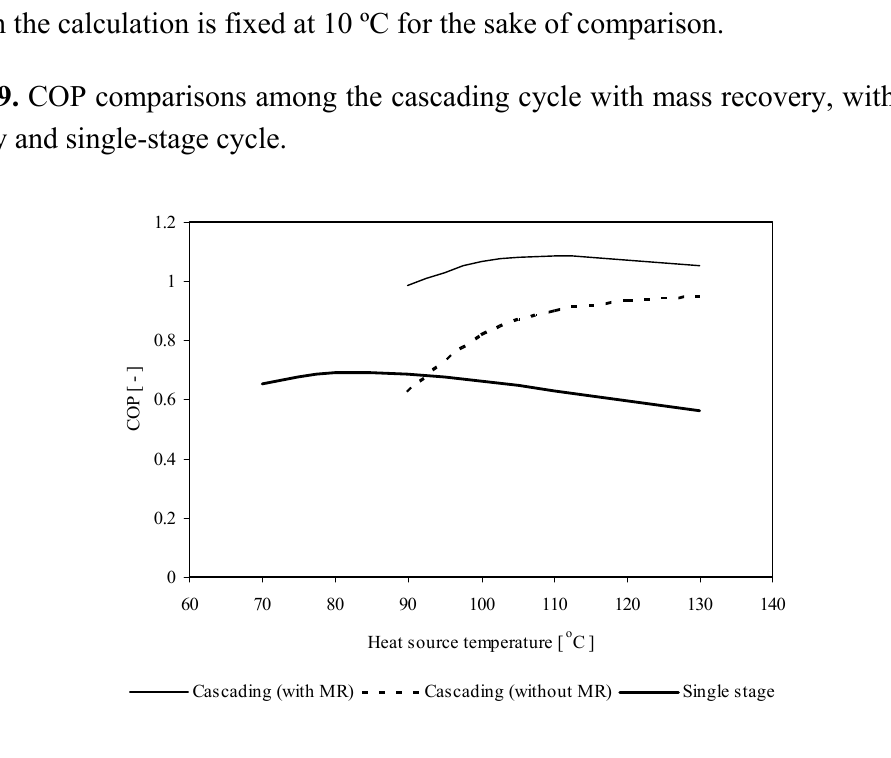
Figure 10. SCP comparisons among the cascading cycle with mass recovery, without mass recovery and single-stage